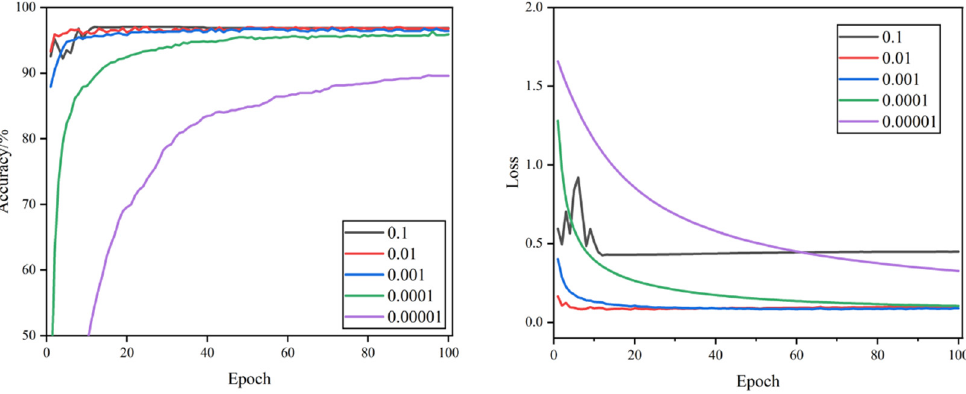
Figure 5. Validation accuracy and loss curves of different learning rates when dropout = 0.